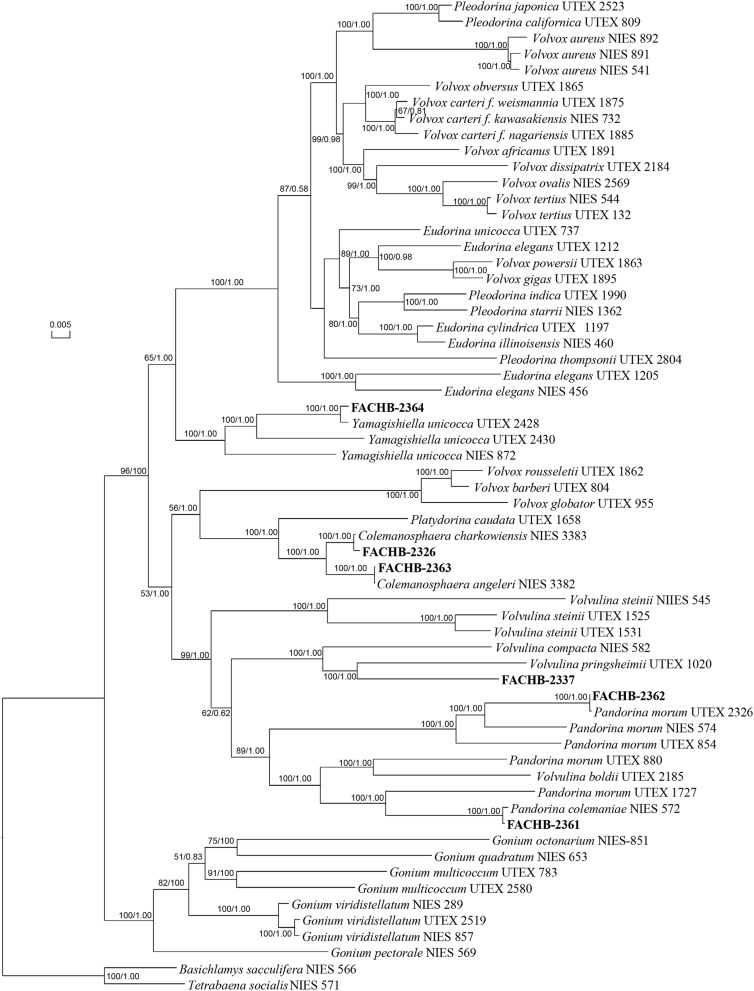
Phylogenetic tree of the colonial volvocine algae based on five chloroplast genes. Numbers on the left and right side at the branches represent bootstrap values and Bayesian posterior probabilities, respectively. Scale bar indicates substitutions per site. Our strains were shown in bold.